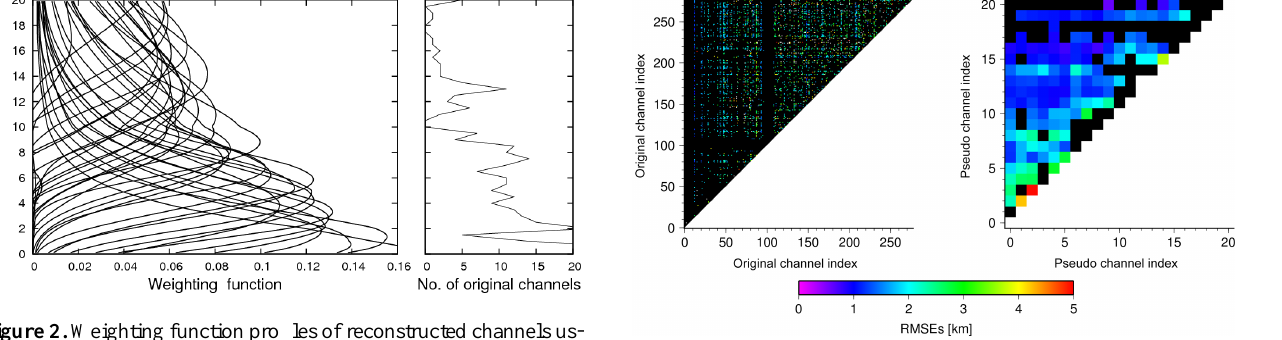
Figure 3. Examples of detection accuracy with spectral biases us- ing the original channel pairs between 700 and 755cm − 1 (left) and the reconstructed channel pairs (right) based on the simultaneous studies with Pstar3. The axes of the left figure correspond to orig- inal channels from 700 to 755cm − 1 and those of right figure cor- respond to the weighting function peak heights of pseudo-channels from 0 to 10km. The clouds with CTHs of 9, 12, 15km and COTs of 0.05–5.0 were assumed for each simulation. The tropical atmo- spheric profile model of AFGL was used. The spectral biases were added randomly to the radiances for each original channel within ± 0.5 K in maximum. RMSEs of retrieved CTH were presented in color. The grid is filled with black if the CTH was not appropriately detectable by more than one